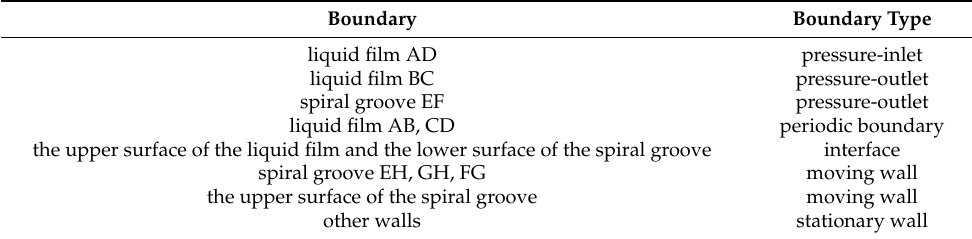
Table 1. Boundary condition settings.